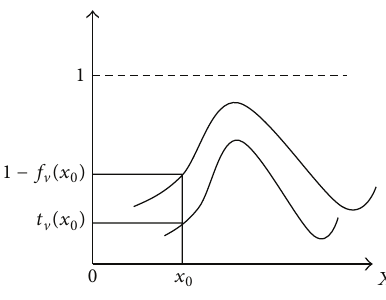
Figure 3: Vague membership